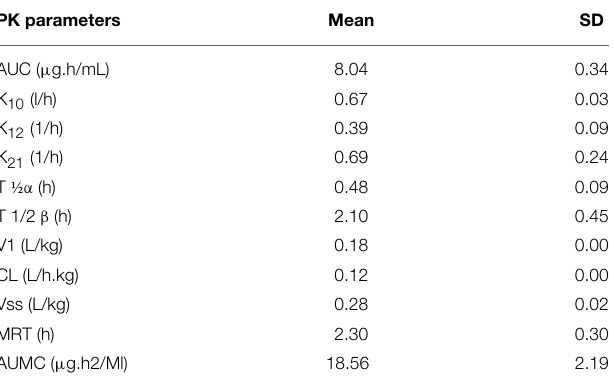
TABLE 1 | Pharmacokinetics parameters after intravenous administration of Cefquinome in cattle at the dose (1mg/kg) body weight. PK parameters